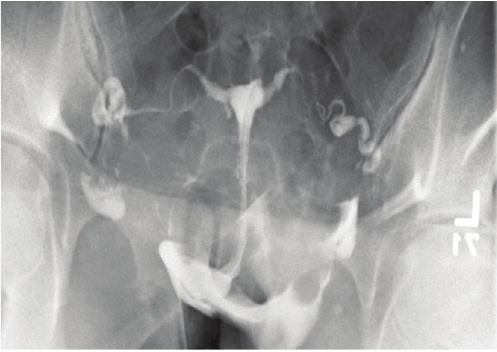
Figure 1: FloSeal is placed at the implantation site ( ∗ ) for hemostasis during a right salpingotomy.